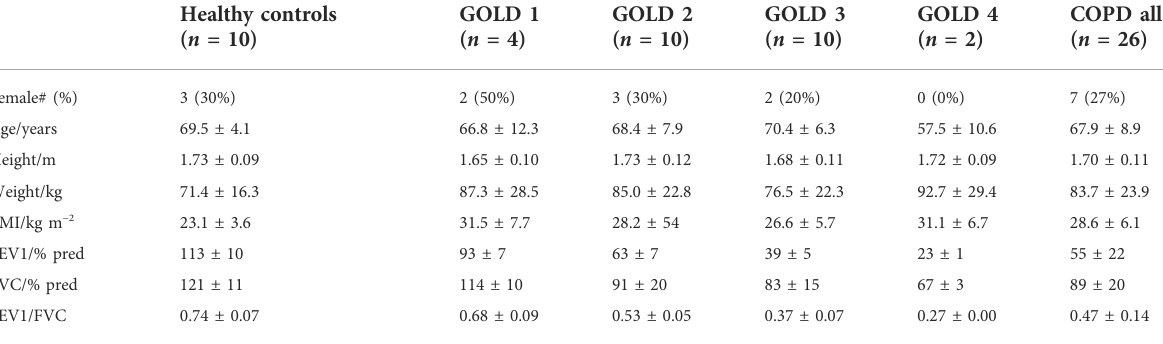
TABLE 1 Anthropometric data for COPD patients and healthy controls. Data are shown as group mean ± standard deviation where applicable. Healthy controls ( n =